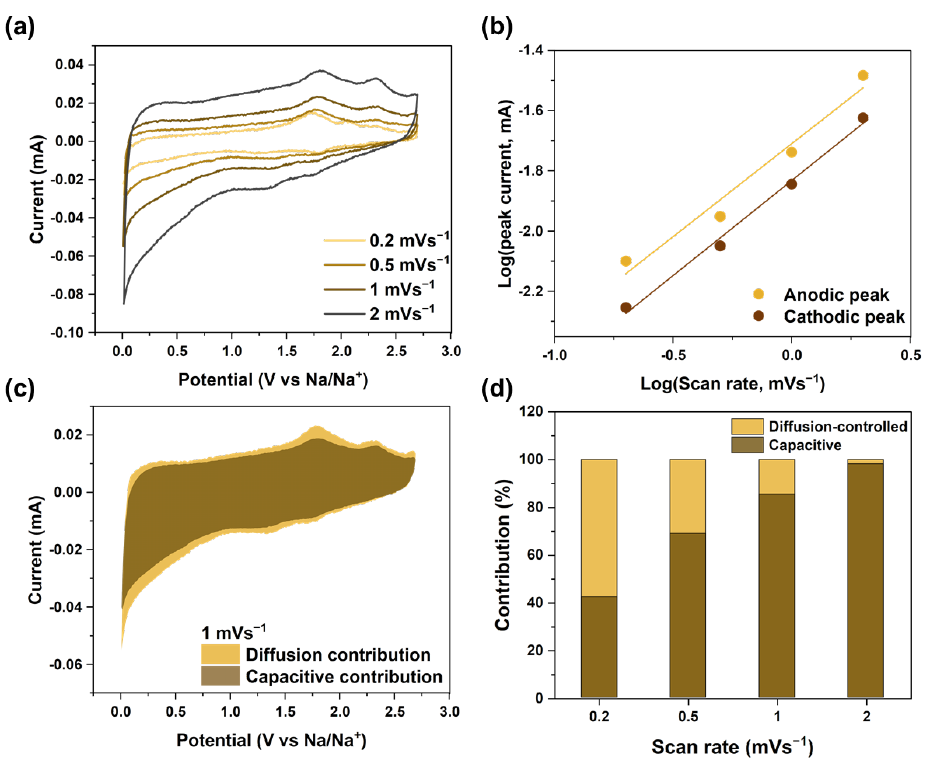
Figure 5. Quantitative capacitive analysis of VSe 2 @MWCNT: ( a ) CV curves at various scan rates from 0.2 to 2 mVs − 1 , ( b ) the relationship between scan rate and peak current, ( c ) the capacity contribution in CV curve at 1 mVs −1 , ( d ) the proportion of capacitive contributions at various scan rates. The value of b close to 0.5 was a diffusion-controlled reaction (Faradaic process). A value close to 1 indicated a capacitive-controlled reaction (non-Faradaic process) [59]. The b value was 0.61 at an oxidation peak of 2.4 V and 0.63 at a reduction peak of 1.3 V (Figure 5b). Electrochemical kinetics at a fixed scan rate could be explained by Equations (5) and (6). The ratio of the capacitive-controlled reaction was given with the value of k 1 ν , while the diffusion-controlled reaction was given with k 2 ν 1/2 [60].